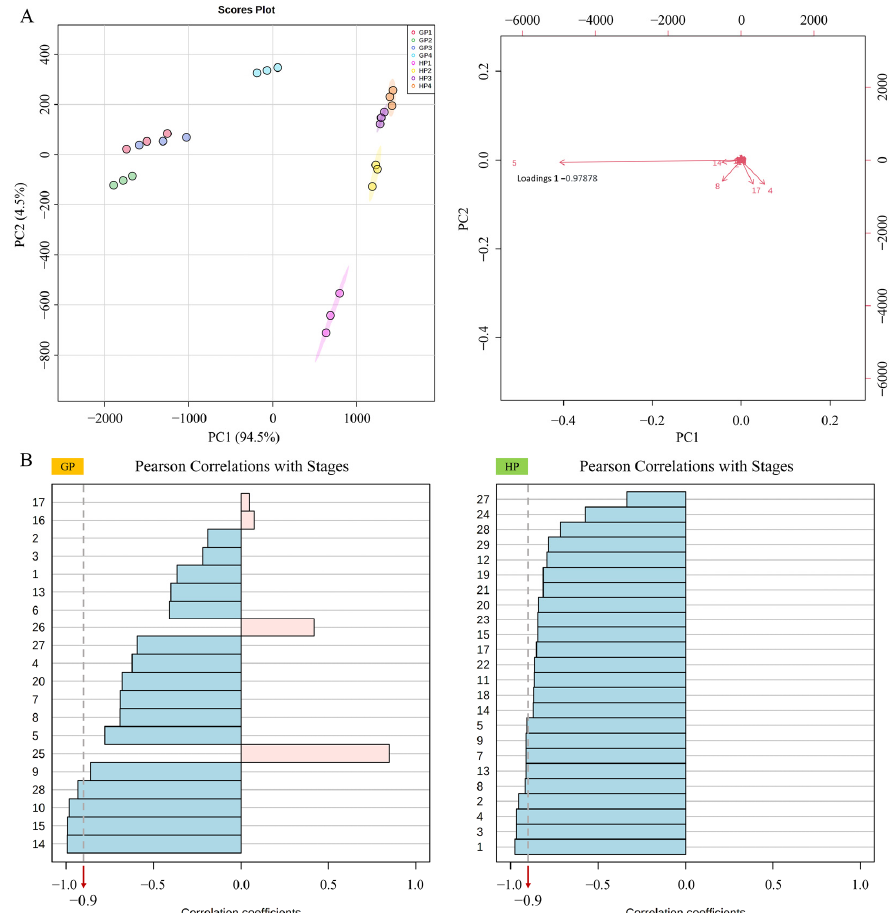
Figure 3. Volatile profiles in young pomelo fruits. The numbers stand for volatiles which could be referred in Table S2. ( A ) PCA analysis results. ( B ) The coefficients of volatiles correlated to development stages in two varieties of young pomelo